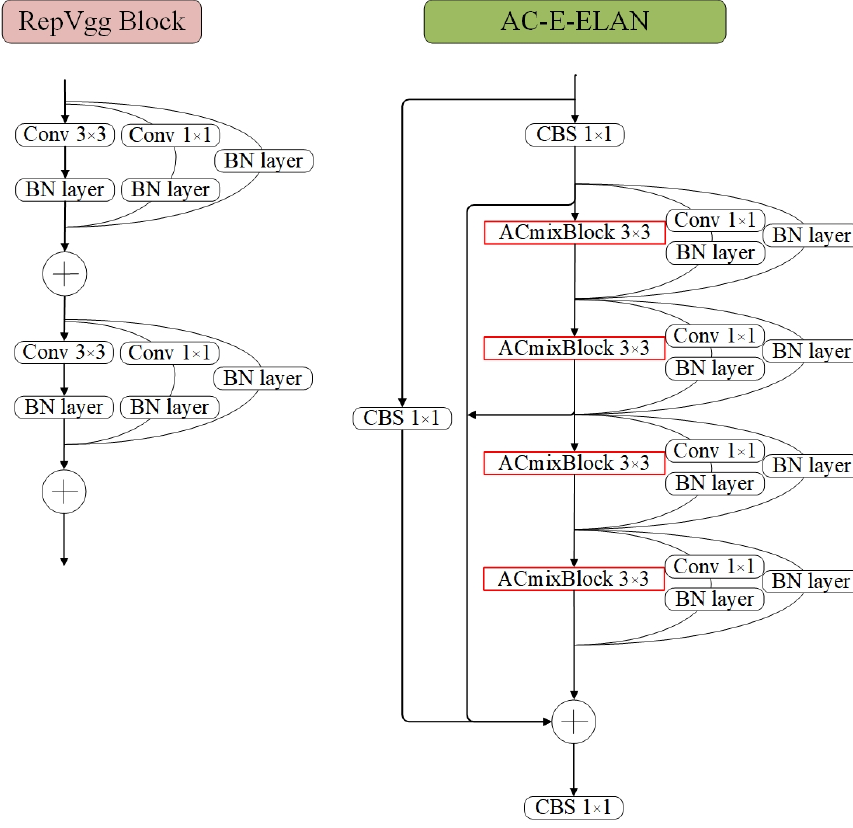
Figure 3. The structure diagram of AC-E-ELAN module ( left : RepVgg; right : AC-E-ELAN).